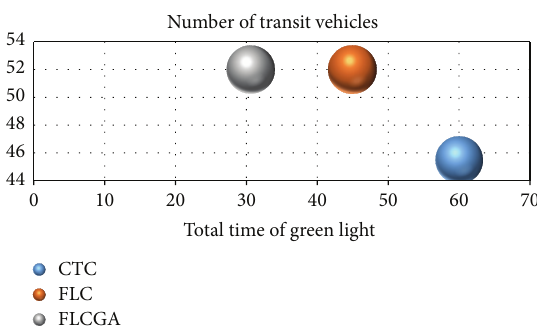
Figure 9: Bar chart of the different methods in determination of green light time